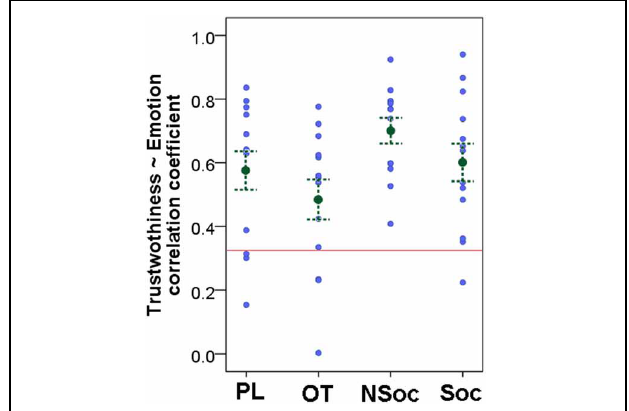
FIGURE 2 | Correlatedness of Trustworthiness and Emotion ratings in the four groups. Mean ± SE; gray dots show individual data; red line indicates significance